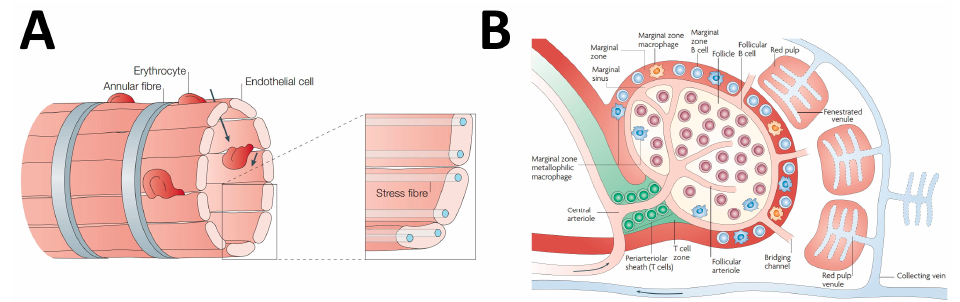
Figure 1. Microanatomy of the spleen circulation. ( A ) Structure of the splenic venous sinuses. The drawing shows how venous sinuses of the splenic red pulp are delimited by endothelial cells arranged in a barrel-like fashion making narrow slits that erythrocytes have to cross to return into the venous circulation. As detailed in the text, aged or damaged cells that are too rigid to cross these slits are retained in the red pulp and phagocytosed by macrophages. Reproduced from [1] with permission from the publisher; ( B ) Structure of the microcirculation of the spleen. The drawing schematically illustrates how small vessels emerging from the penicillary artery form the marginal sinuses at the boundary between white and red pulp. The marginal zone with its specific cell populations such as metallophilic macrophages is represented, as well. Notice that in this pictorial representation, a model of open splenic circulation was adopted with penicillary arteries freely opening in red pulp. Reproduced from [15] with permission from the